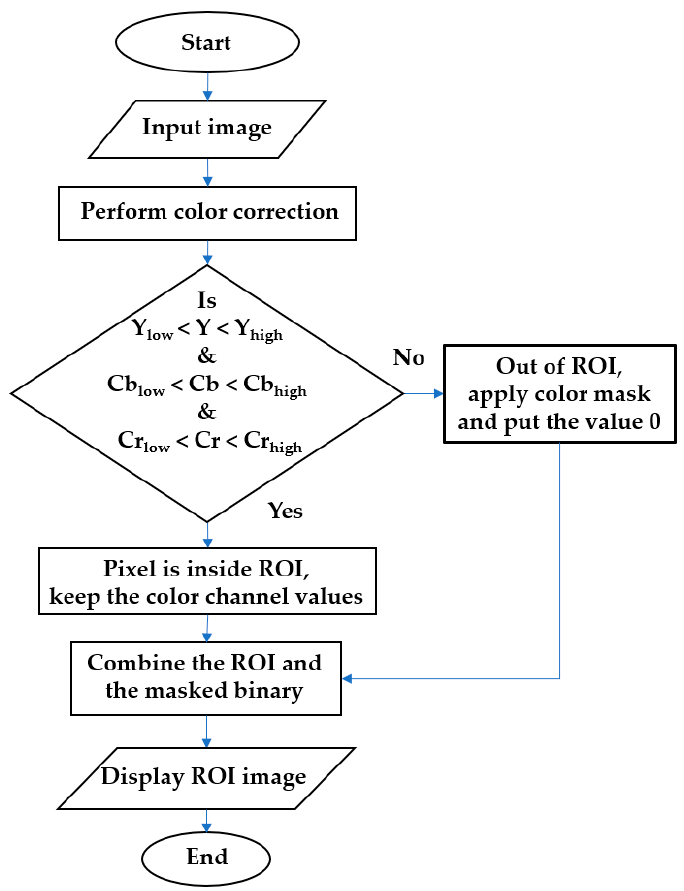
Figure 6. Flowchart of the image segmentation step of our proposed method. The image segmentation step extracts the region of interest (ROI) from the original image.